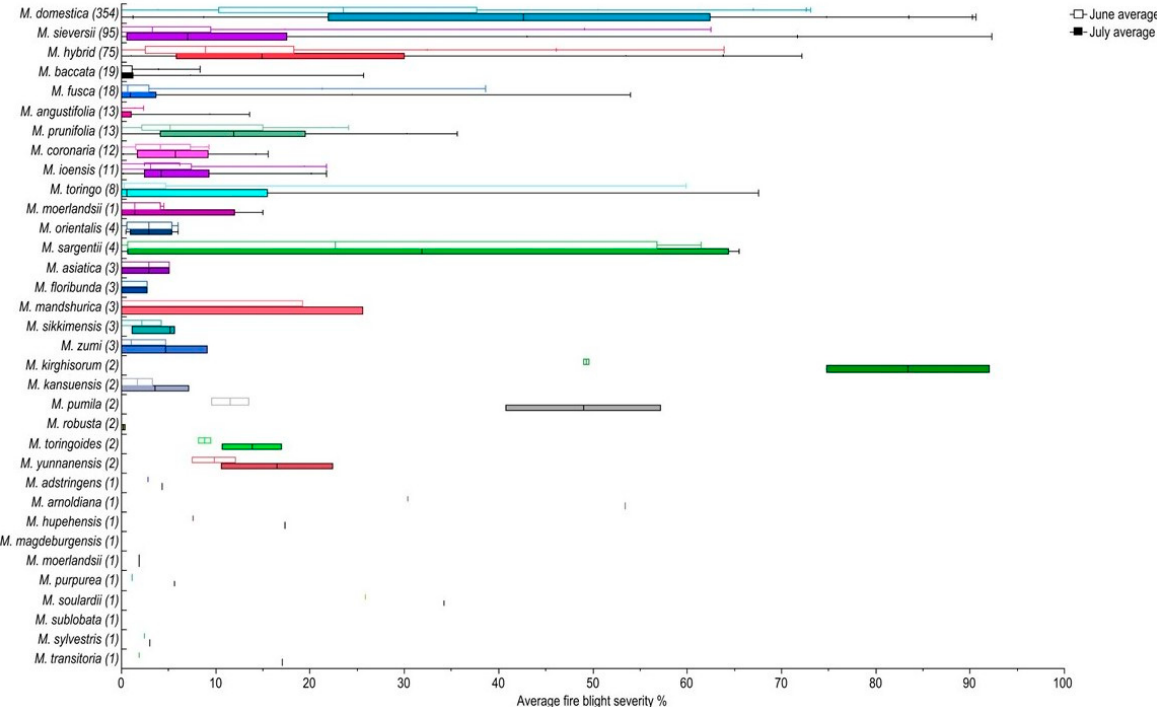
Figure 4. Quantile box plots of 667 main collection subset scored for fire blight severity in June and July. June is shown as open bars and July is shown as filled bars. The box indicates the 25th and 75th quantile and the median is shown as a colored line in the June box and a black line in the July box. The number of trees scored per species is shown in parenthesis. Species are ordered by descending tree count. Box plot colors delimitate species.